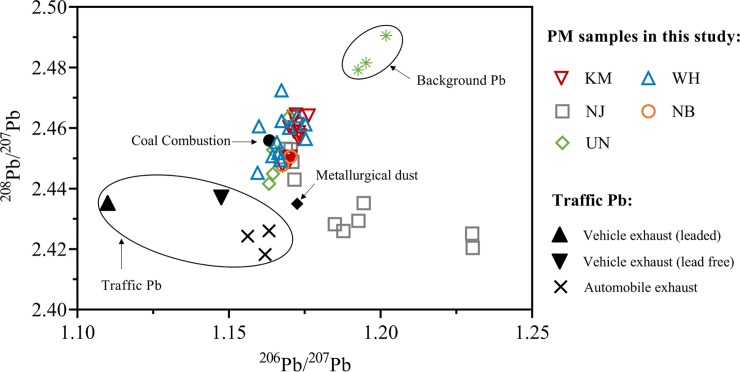
Lead isotopic compositions (206Pb/207Pb, 208Pb/207Pb) for PM samples collected at KM, WH, NJ, NB and UN.Lead isotopic compositions for background, coal combustion, metallurgical dust and traffic sources were obtained from Zhou et al. (2001) [46], and Tan [47].